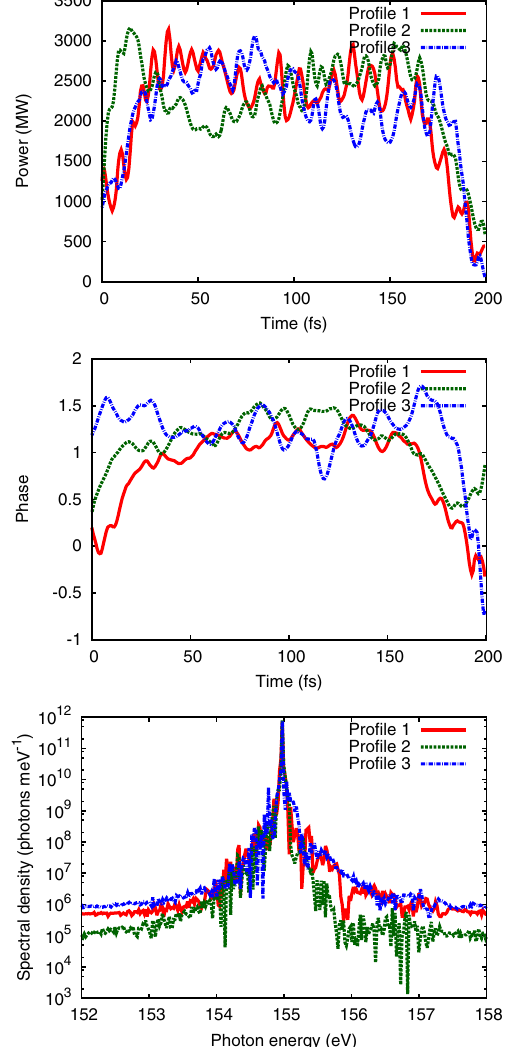
FIG. 6. Radiation characteristics at 8 nm at saturation, showing power (top), phase (middle), and spectrum